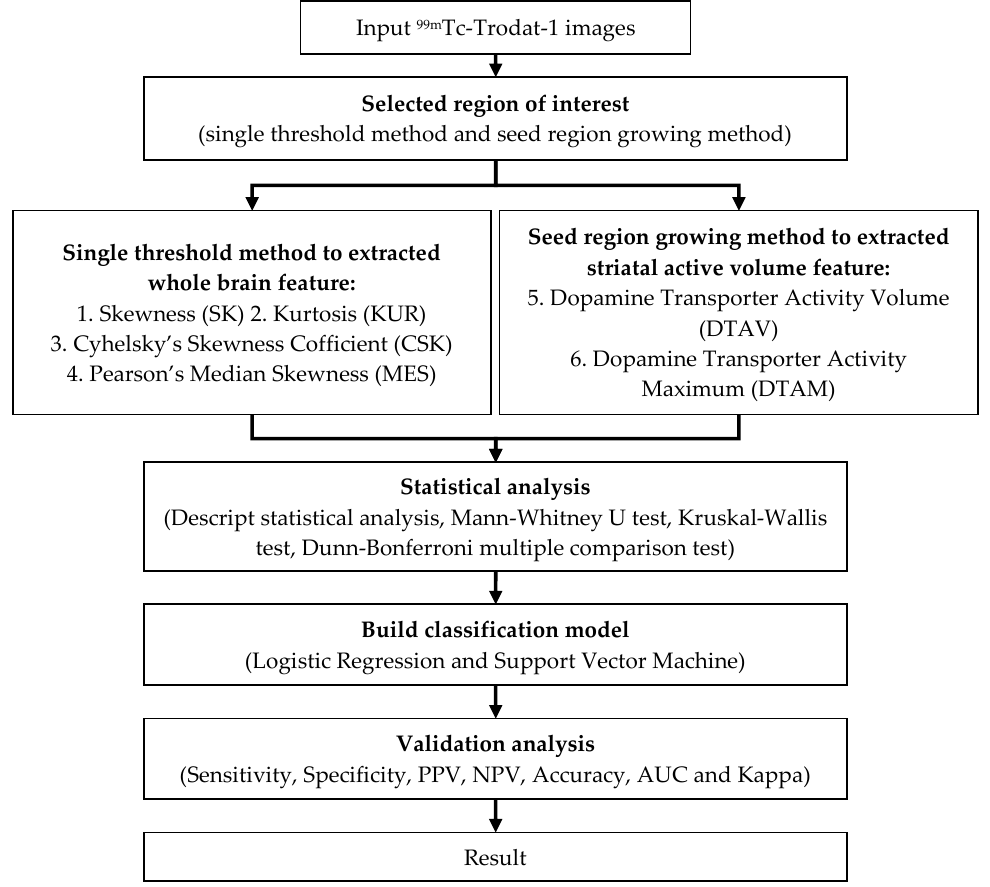
Figure 2. A flow chart of experimental design.